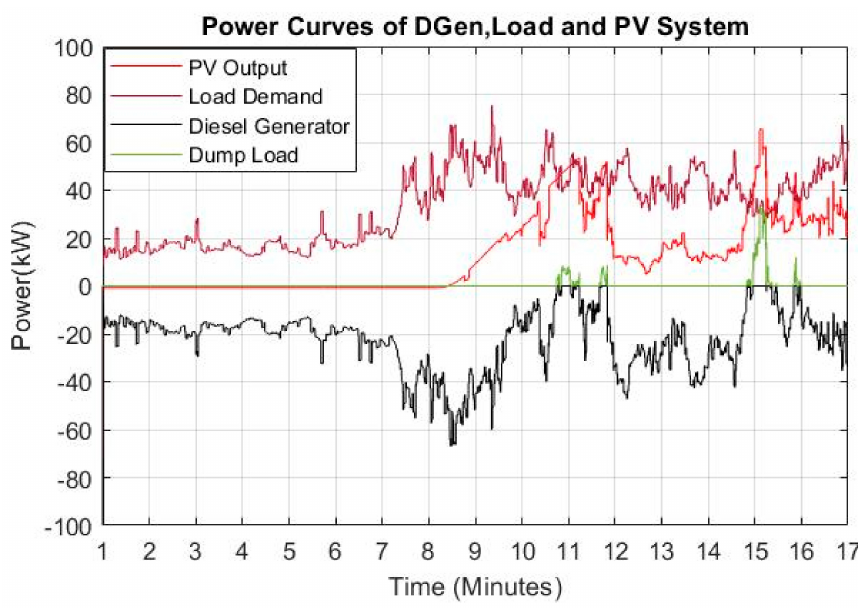
Figure 15. Power curves of Dgen, load demand and PV system for load profile 2.